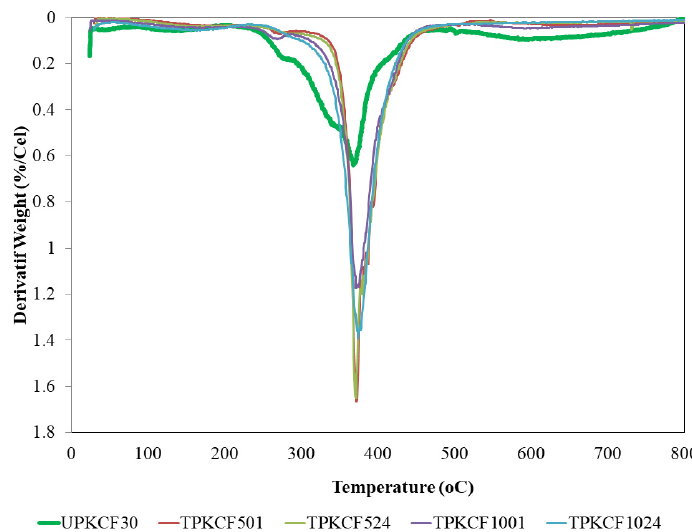
Figure 12. DTG curves of untreated and treated PKCF/ER composites.